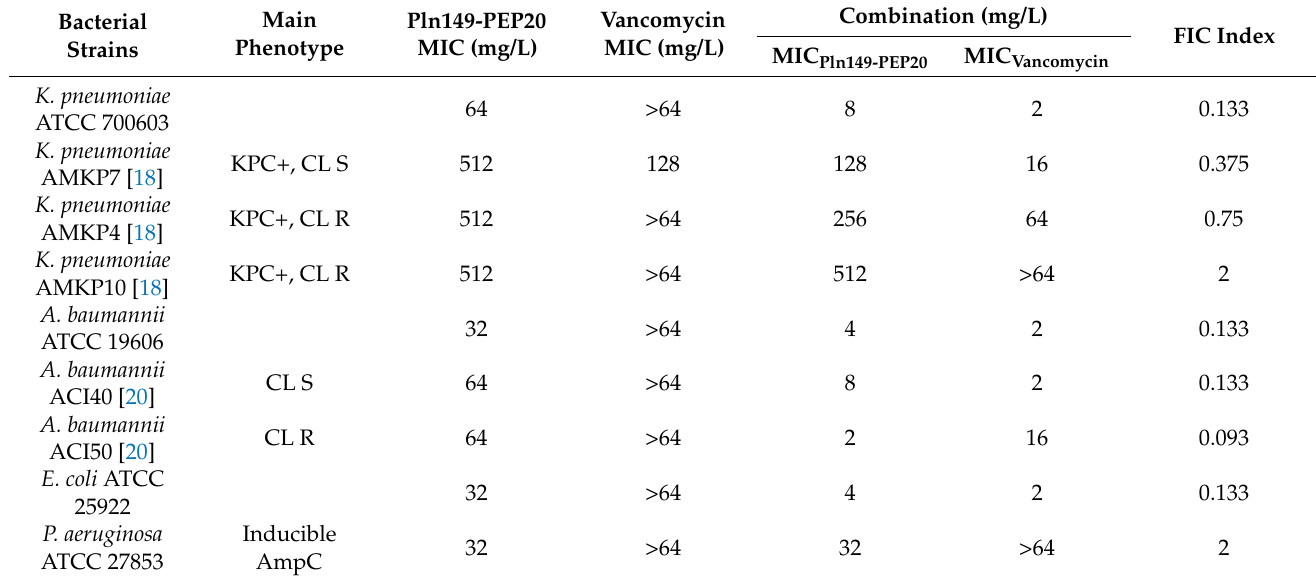
Table 5. Synergism of Gram-negative strains for Pln149-PEP20 and